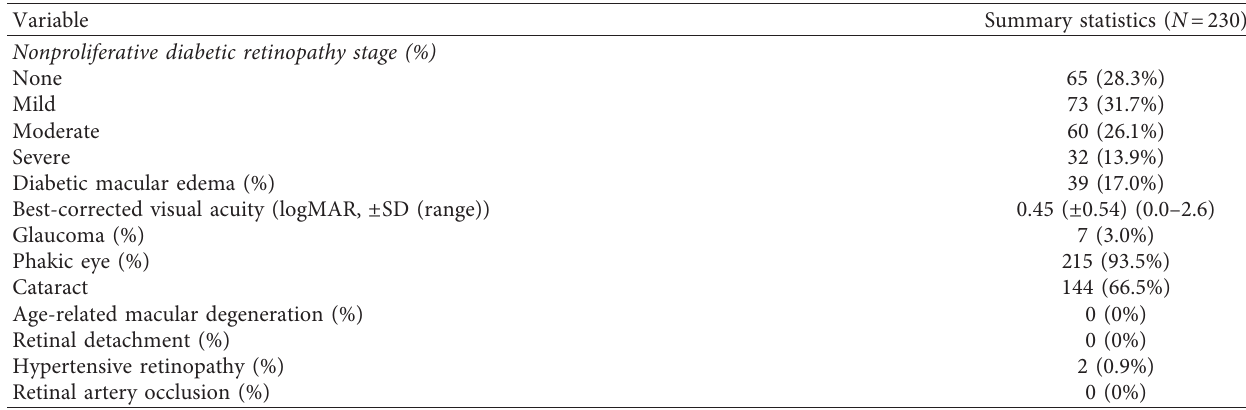
Table 3: Summary of baseline ocular